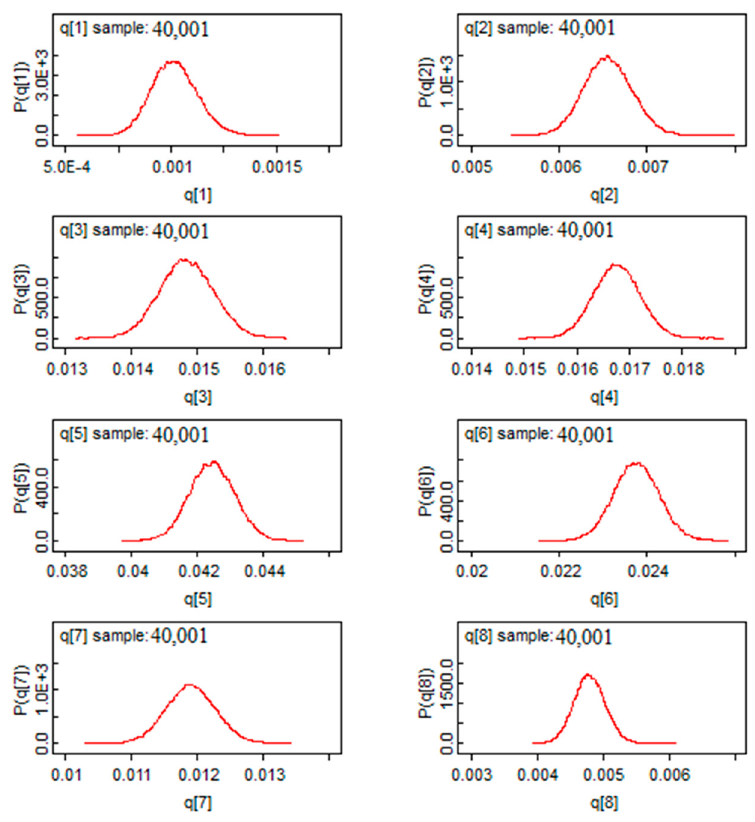
Figure 15. The post hoc distribution of infection rates for the first provinces.